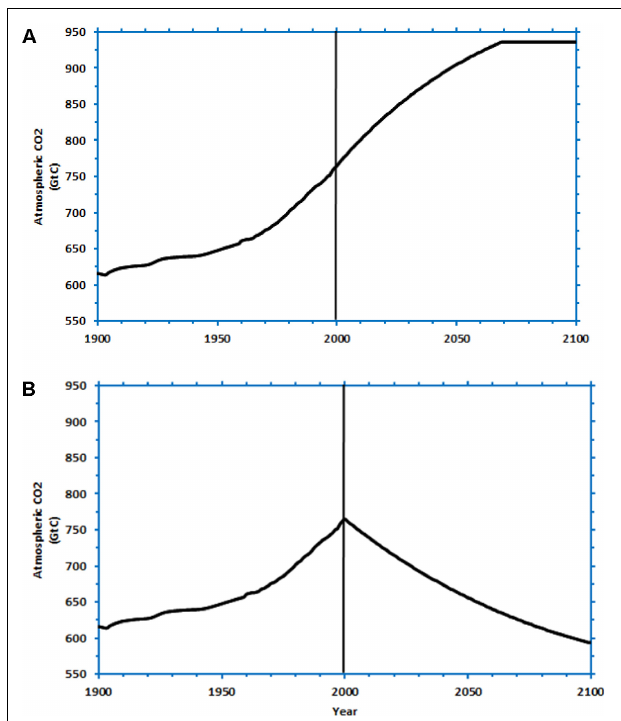
FIGURE 4 | The CO 2 concentration trajectory given to participants in the DCCS-Structure condition. (A) The increasing CO 2 concentration trajectory, where stabilization occurs in year 2070 (DCCS-2070; CS-2100-Inc). (B) The decreasing CO 2 concentration trajectory, where stabilization occurs in the year 2100